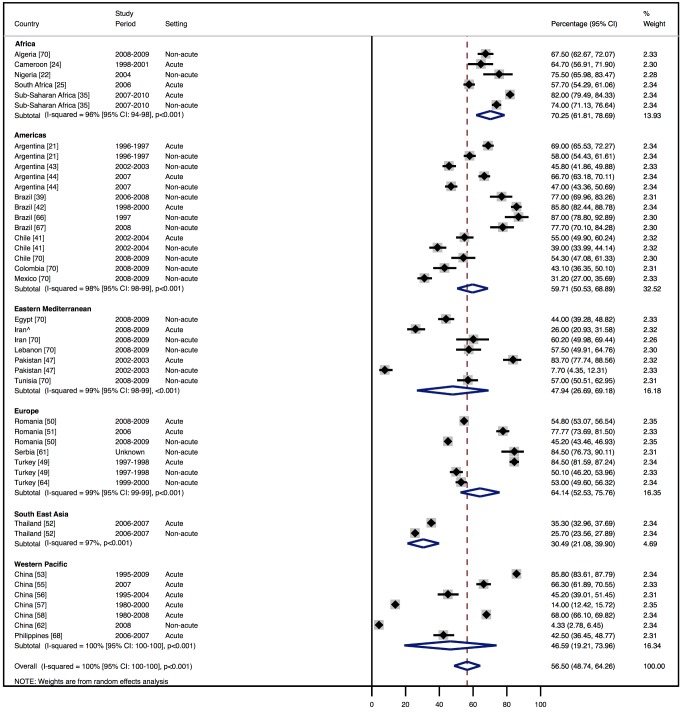
Angiotensin-converting enzyme inhibitor use by region.∧Rahimzadeh S, Farzadfar F, Ghaziani M (2013) Iranian hospital data project (unpublished data).